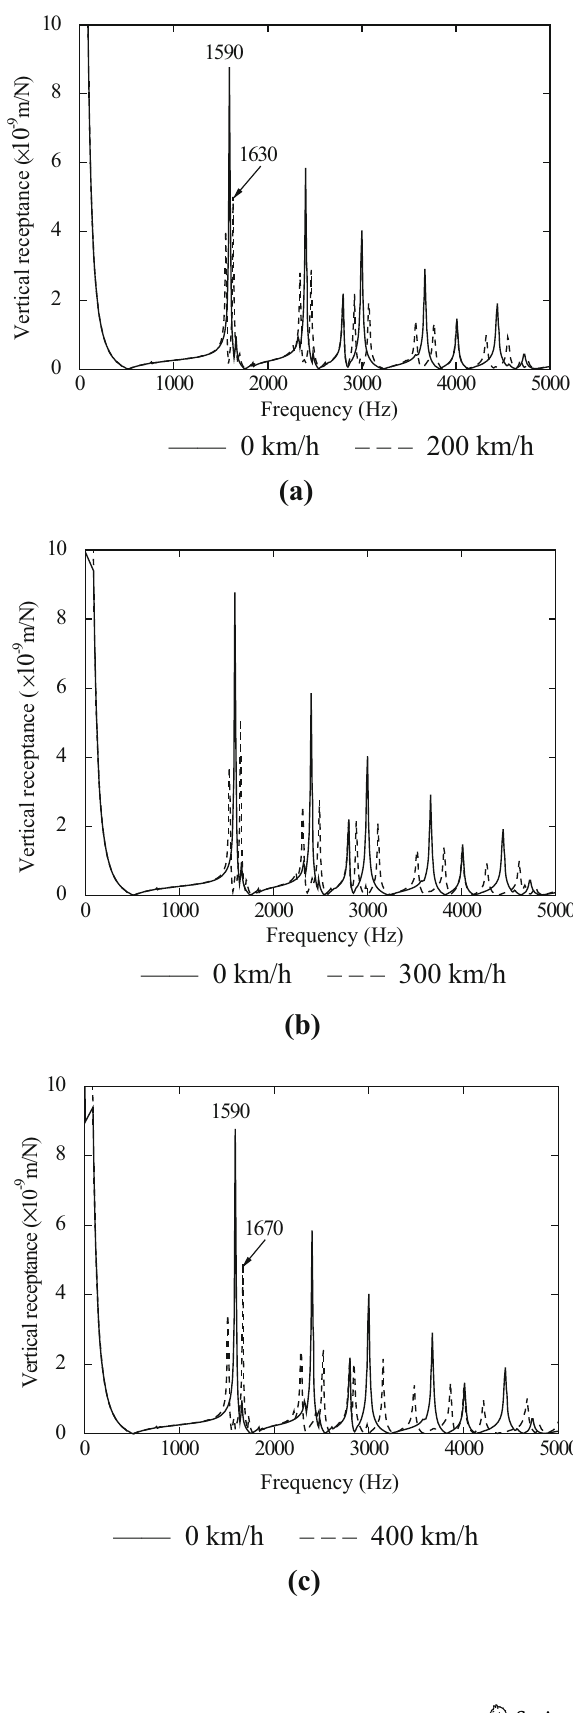
c Fig. 6 Influence of the rotation speed on the wheel